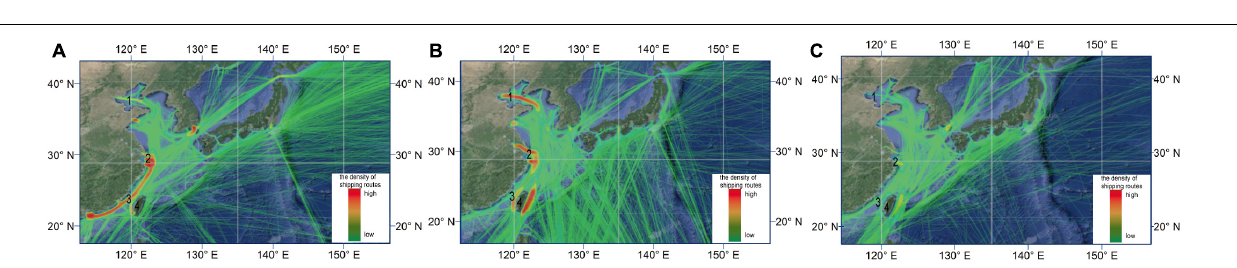
FIGURE 10 | Thermal map of megaship tracks around China based on more than 5,000 TEU of containers (A) , more than 100,000 tons of bulk cargo (B) , and more than 100,000 tons of tankers (C) 1, the Bohai Bay; 2, the Changjiang Estuary; 3, the Taiwan Strait; 4, the Taiwan Island ( Source: Shipping News, 2020